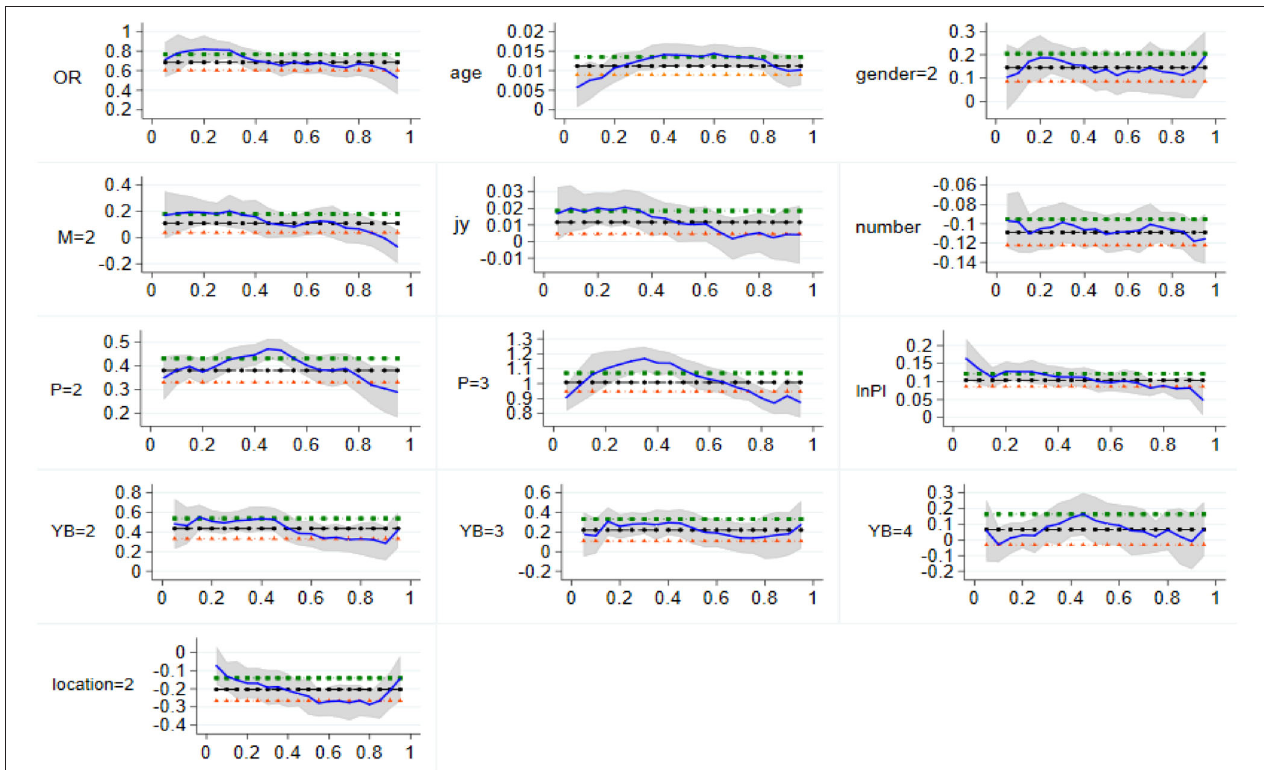
FIGURE 1 | Change of quantile regression coefficient of the national sample. The vertical coordinate is the estimated value, whereas the horizontal coordinate is the different quantiles.